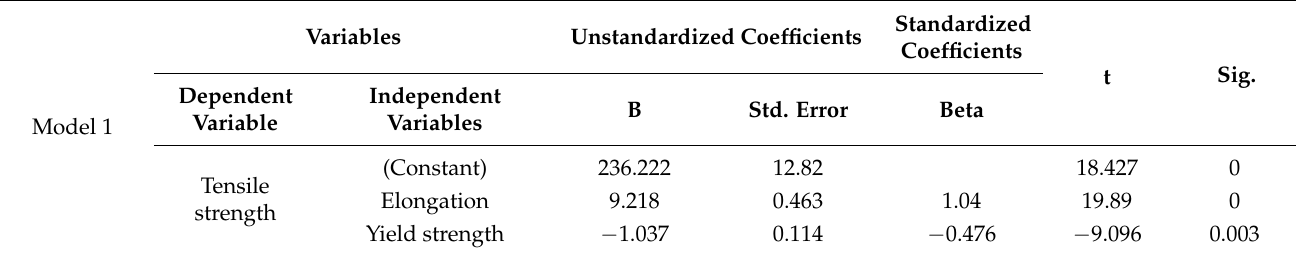
Table A4. Linear relationship between tensile strength with elongation and yield